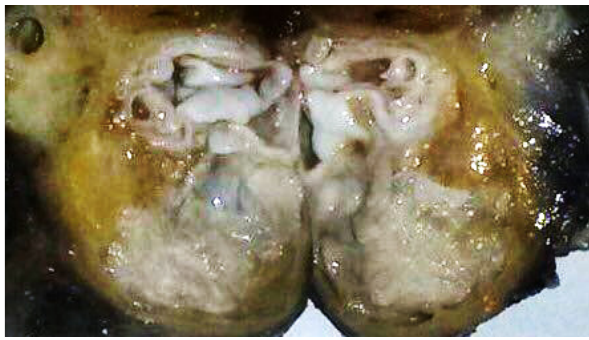
Figure 2: A cystic lesion with smooth whitish wall in lower pole left thyroid lobe.